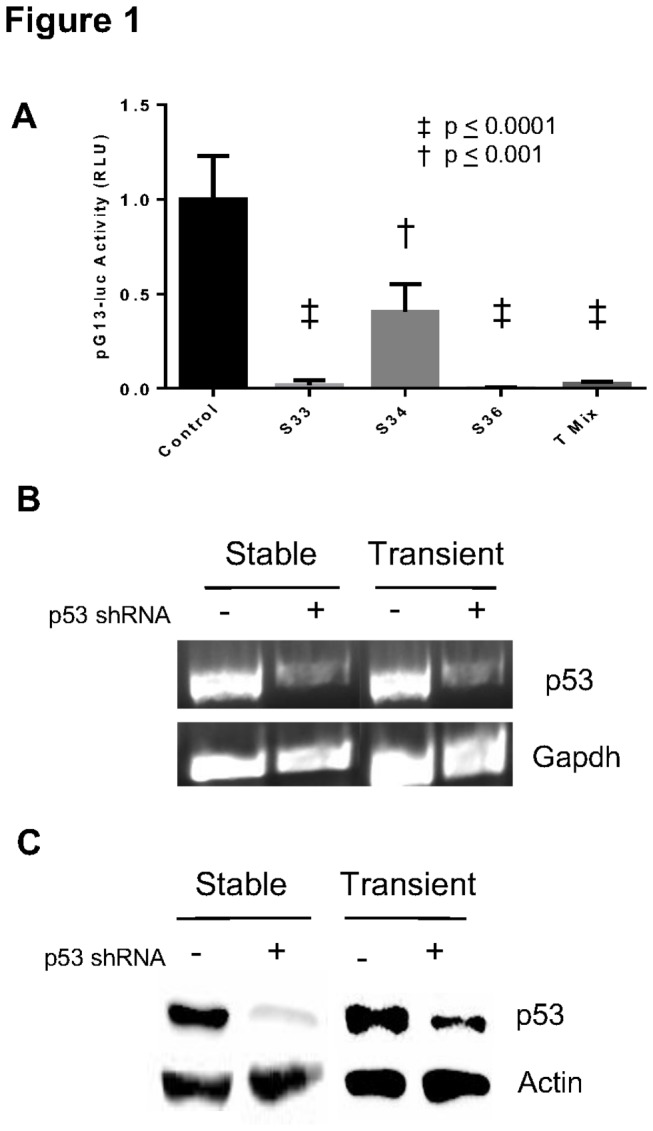
Confirmation of stable and transient knockdown of p53(A) Transcriptional activity of p53 is reduced with reduction in p53 levels Mean + S.E.M. of relative luciferase units (RLU) reported for stable (S) knockdown of p53 using shRNA plasmids and a transient knockdown using a mix of all three plasmids (T Mix) when compared to controls receiving scrambled shRNA sequences. (B) RT-PCR of p53 from a stable knockdown (S33), a transient knockdown (T33) and control (scrambled shRNA). (C) Immunoblot of p53 expression in a stable (S36) line and after transient knockdown of p53 (T36). The same blot was stripped and reprobed with anti-actin antibody. Similar results were obtained in three independent experiments and representative data are shown.